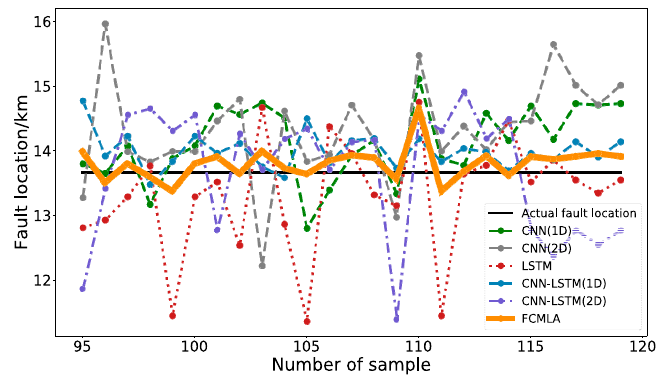
Figure 7. Predicted and real values for different decomposition models.